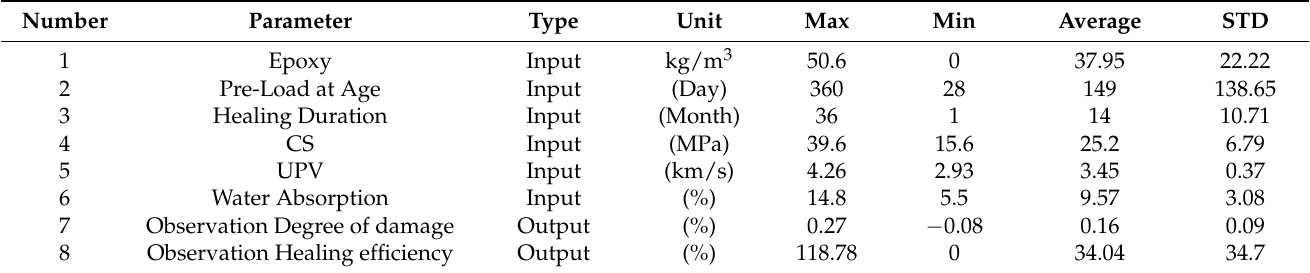
Table 4. Characteristics of studied input and output parameters.